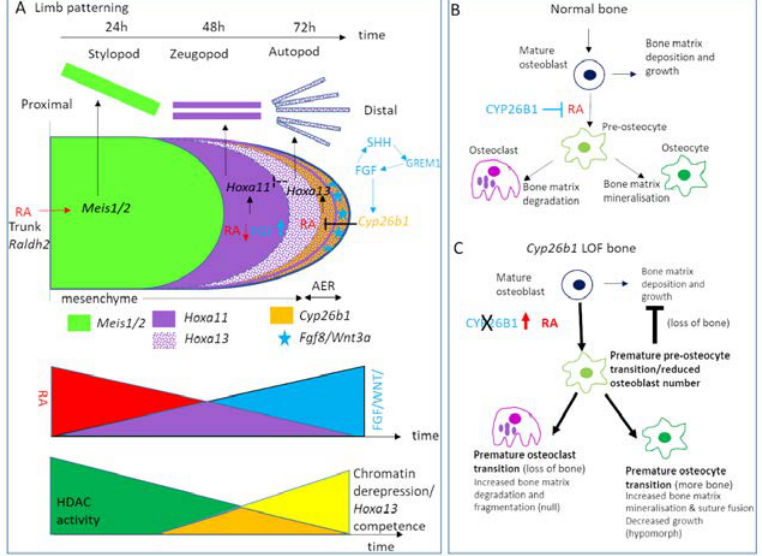
Figure 6. Roles for CYP26 enzymes in limb patterning and chondrogenic development. ( A ). Expression of Cyp26b1 in the apical ectodermal ridge and underlying mesenchyme induced by FGF8 signalling is required to degrade RA synthesised by RALDH2 in the trunk of the embryo near the outgrowing limb bud. This establishes an opposing proximodistal (PD) RA gradient to the FGF/WNT PD gradient. High RA is required to specify the most proximal limb element the stylopod by inducing Meis1/2 expression. Reduced RA levels at a point along the PD gradient inhibit Meis expression and in conjunction with FGF signals, promote expression of distal Hox gene Hoxa11 , necessary to specify the zeugopod. Further reduction of RA levels distally by CYP26B1 degradation permits more distal Hoxa13 expression, once time-dependent HDAC activity is sufficiently reduced to allow chromatin derepression. This mediates competence for Hoxa13 expression in the limb mesenchyme and thus specification of the most distal limb element, the autopod. Adapted from Rosello-Diez et al. 2014 [204] ( B ). Role of Cyp26b1 in regulating RA signalling to prevent premature transition from mature osteoblasts producing bone matrix to bone mineralising osteocysts and bone degrading osteoclasts. ( C ). Loss of RA degradation by CYP26B1 leads to a range of phenotypes resulting from premature osteocyte and osteoclast differentiation including loss of bone due to decreased osteoblasts producing bone matrix and increased numbers of bone degrading osteoclasts plus increased osteocytic bone mineralisation. Adapted from Laue et al. 2011 [202].